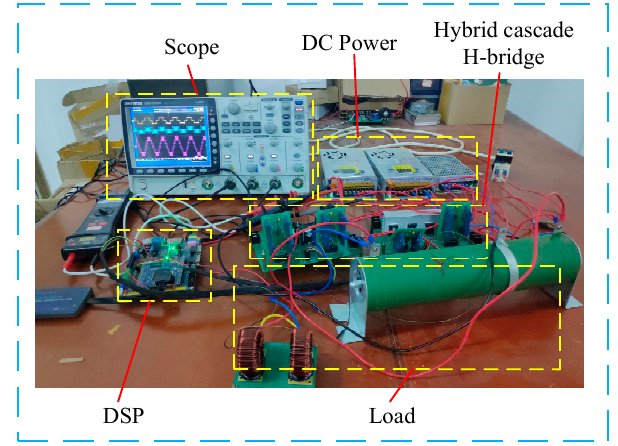
Figure 12. Experiment platform of hybrid cascaded 7-level inverter. Table 3. Key parameters of the